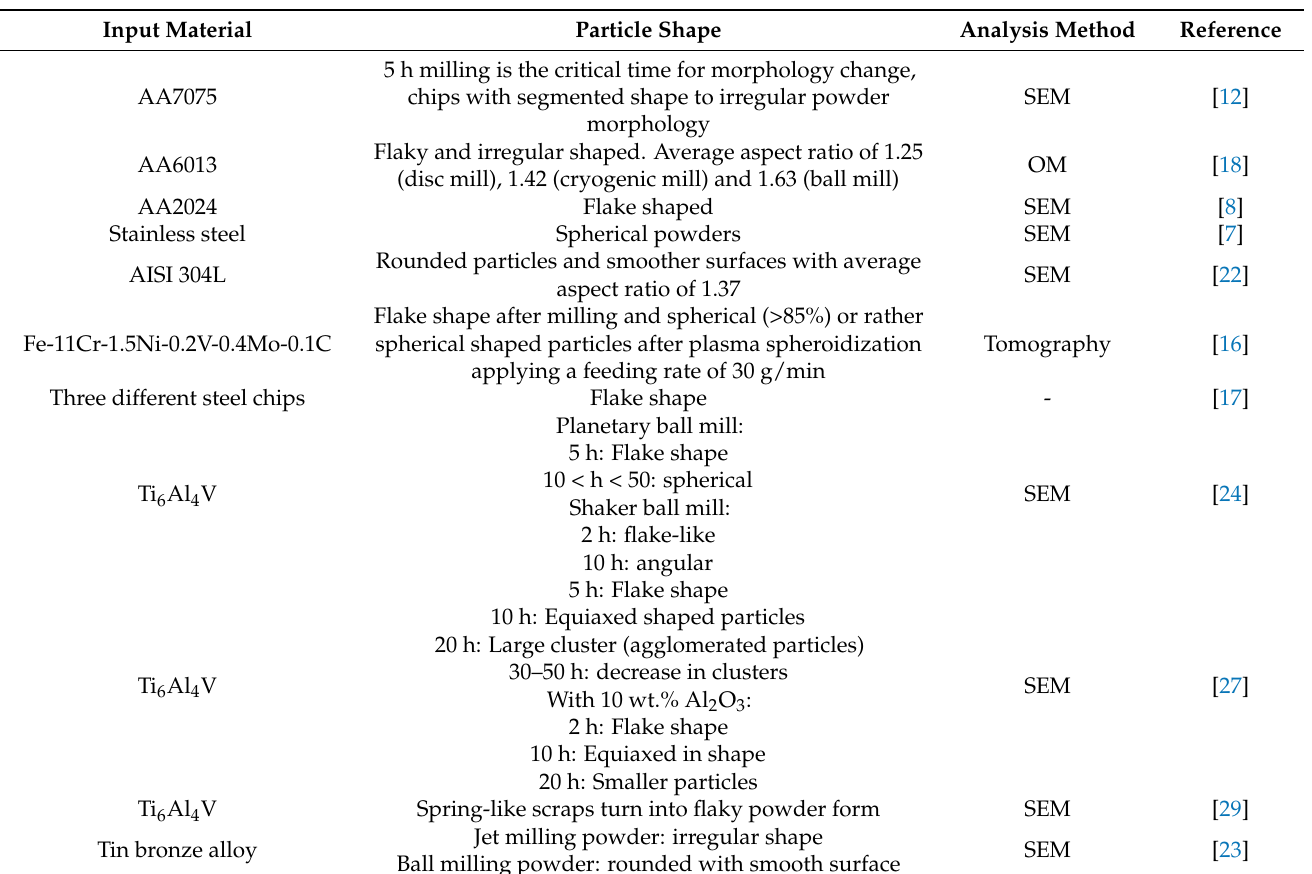
Table 3. Particle